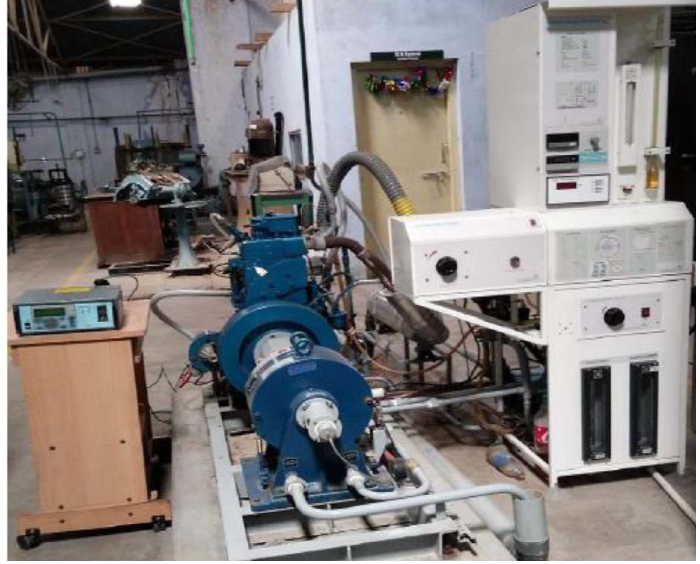
Fig. 1. Test engine set up.